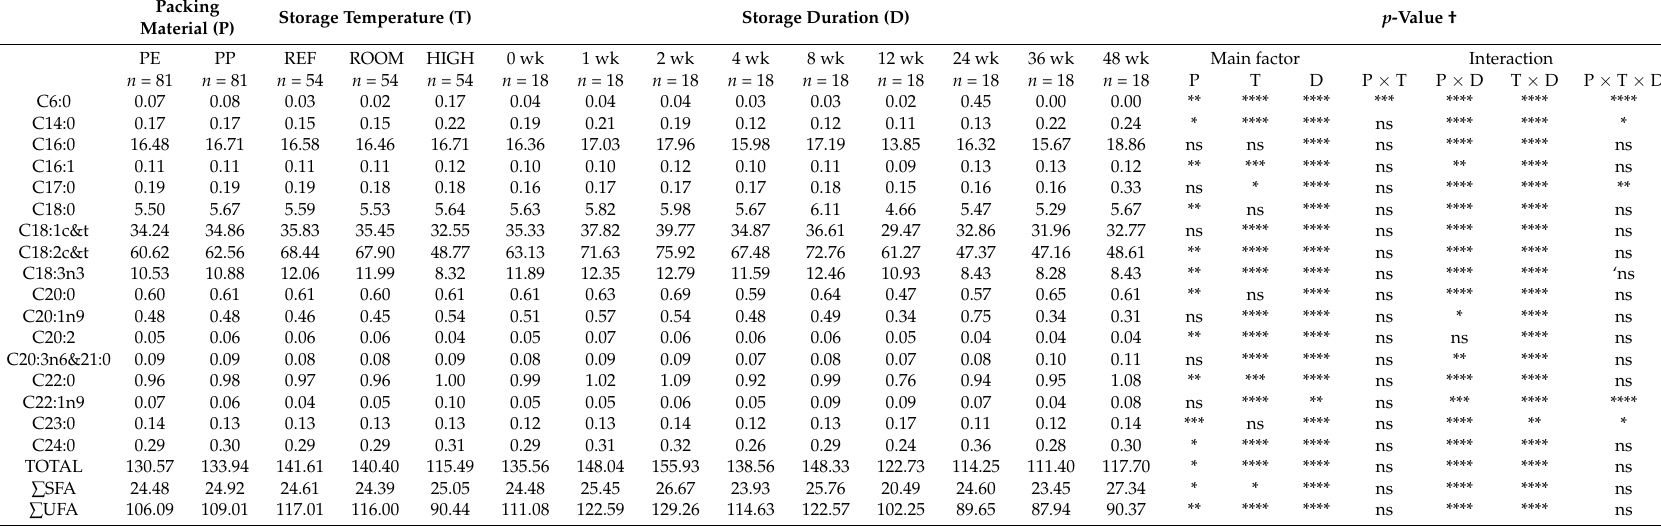
Table 2. Comparison of roasted soybean flour fatty-acid composition and content (mg · g − 1 ) based on packaging material, storage temperature, storage duration, and the associated ANOVA p -value for the main factor and their